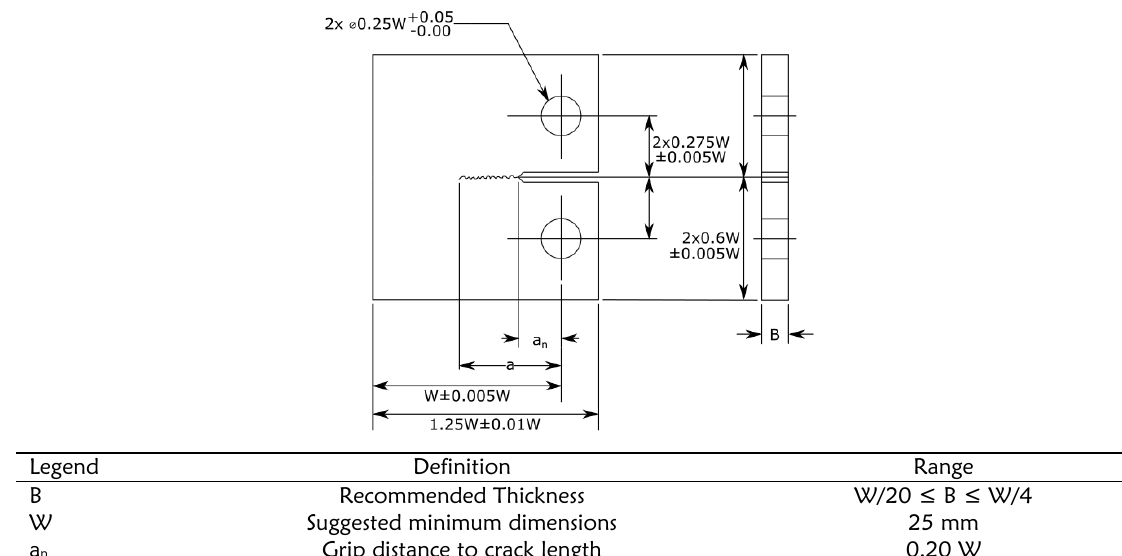
Figure 7: Test specimen used in ASTM E647 standard used to study fatigue crack growth behaviour [15].